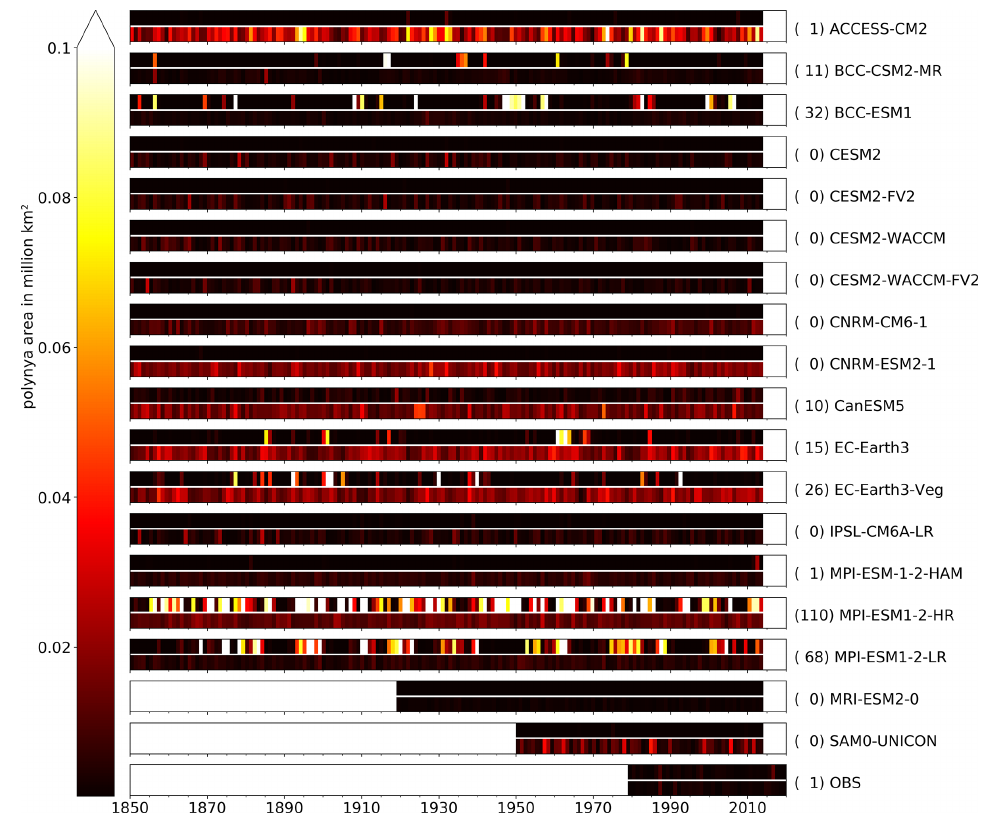
Figure A7. Yearly mean polynya area between May and November in the historical CMIP6 model run for the Weddell Sea region, computed from daily sea ice concentrations. Each bar represents one CMIP6 model and is divided horizontally into coastal polynya area (upper bar) and OWP area (lower bar). The values next to the model name represent the number of years an open-water polynya with an area of more than 10 . 0 × 10 3 km 2 was detected.